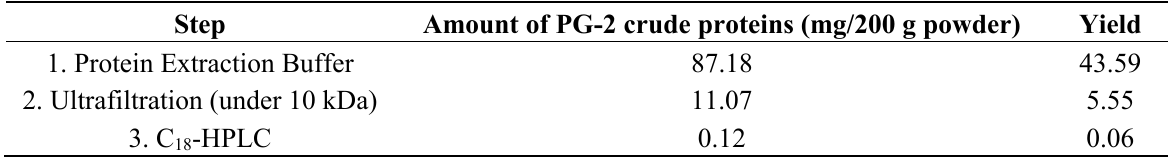
Table 1. Steps in the purification of PG-2 from potato